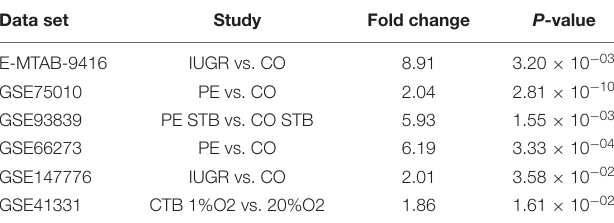
TABLE 2 | Genome-wide transcriptomic studies showing up-regulation of UCA1 either in preeclampsia or intrauterine growth retardation. Data